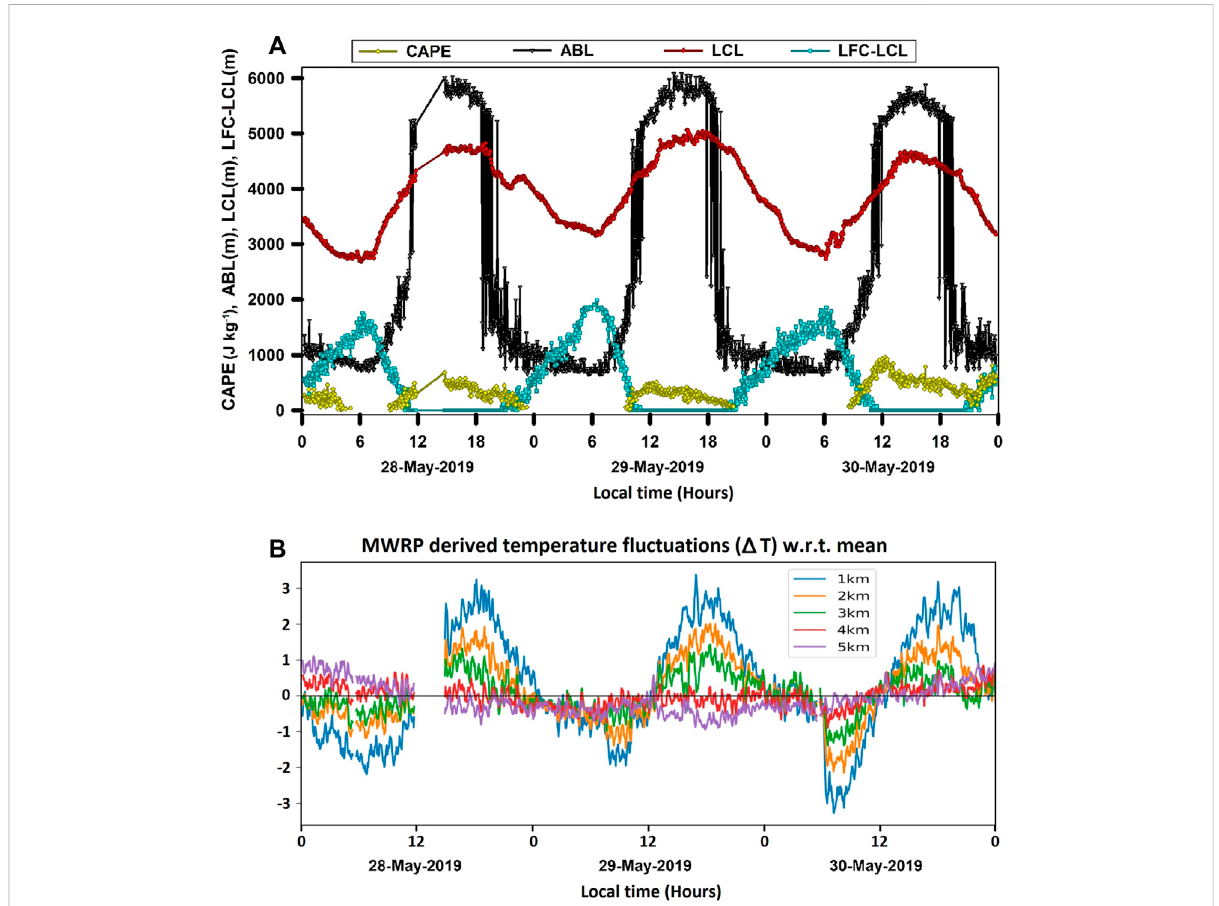
FIGURE 5 Temporal variation of MWRP derived parameters (A) LCL height, ABL height, LFC-LCL height, CAPE and (B) Temperature fl uctuations observed during the period 28 – 30 May 2019. Temperature fl uctuation are deviations from daily